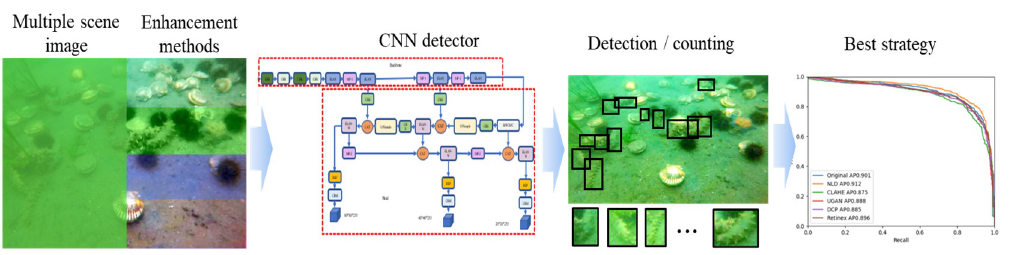
Figure 1. Sea cucumber detection strategy across multiple